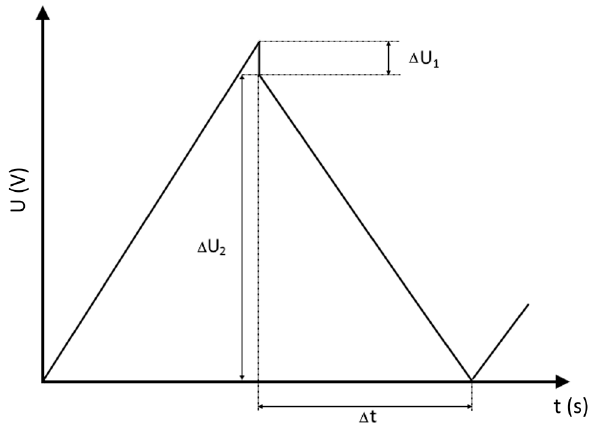
Figure 7. An image of an ideal charging/discharging process on the basis of which the parameters of the supercapacitor were determined.